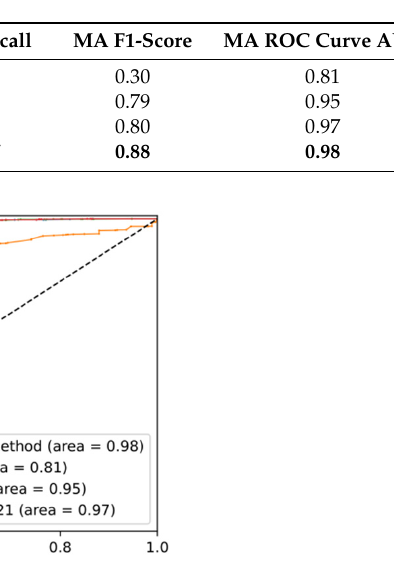
Table 6. Macro-average measures for all CNN models.